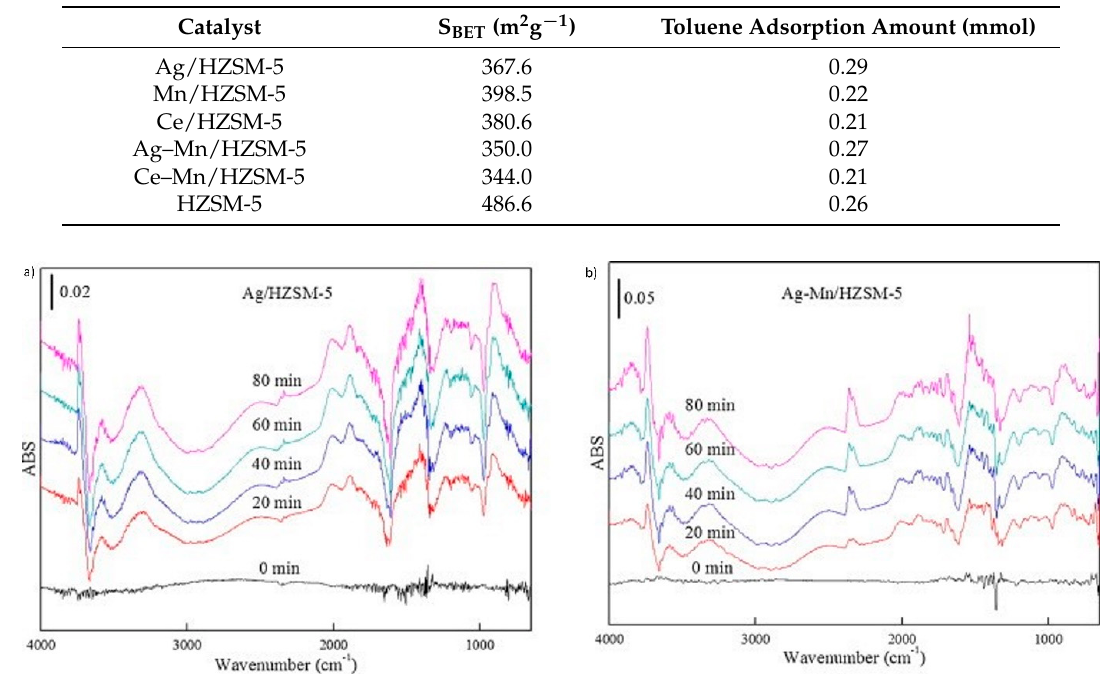
Table 2. Specific surface area and toluene adsorption capacity of different metal loaded HZSM-5 zeolite (amount of catalyst = 1.6 g) [38].